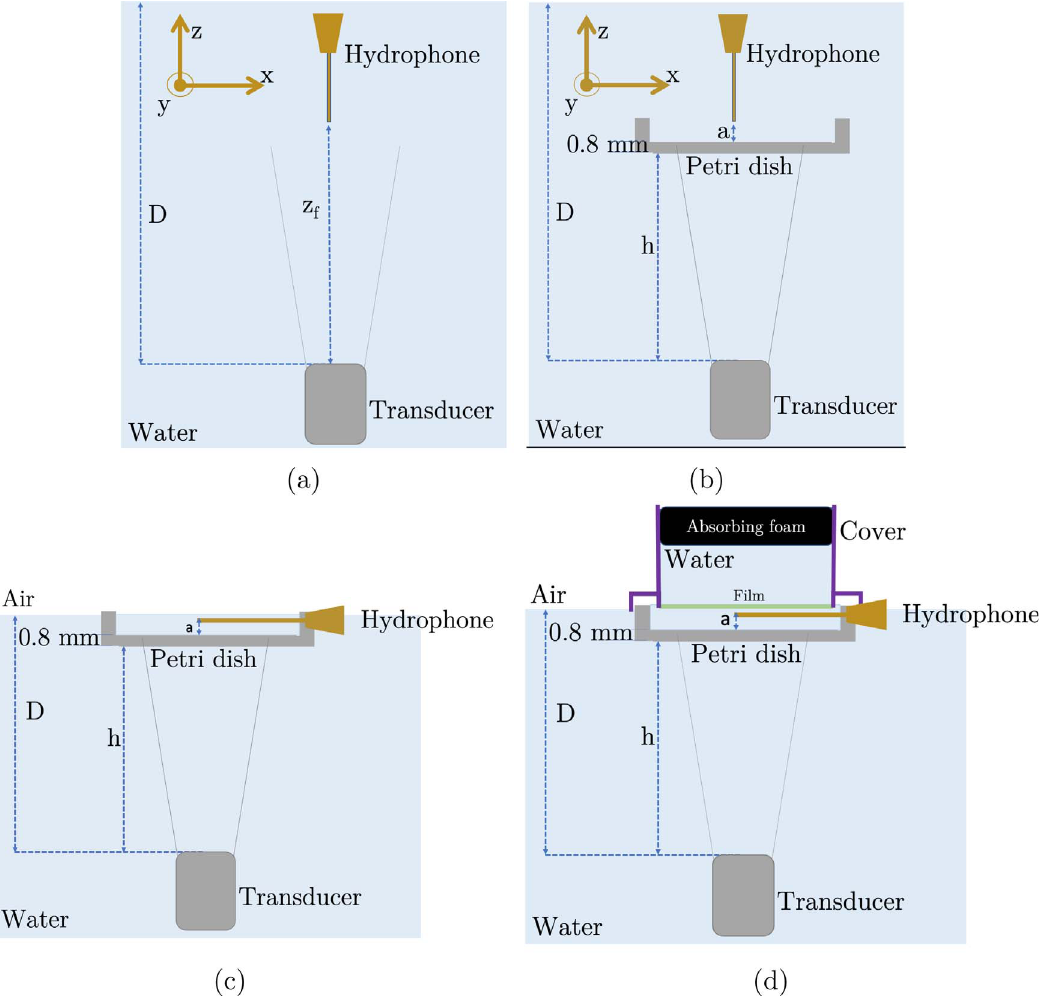
Figure 3. Schematic drawings of high water level con fi guration (a) without and (b) with the Petri dish and low water level con fi guration (c) without and (d) with the anti-re fl ection